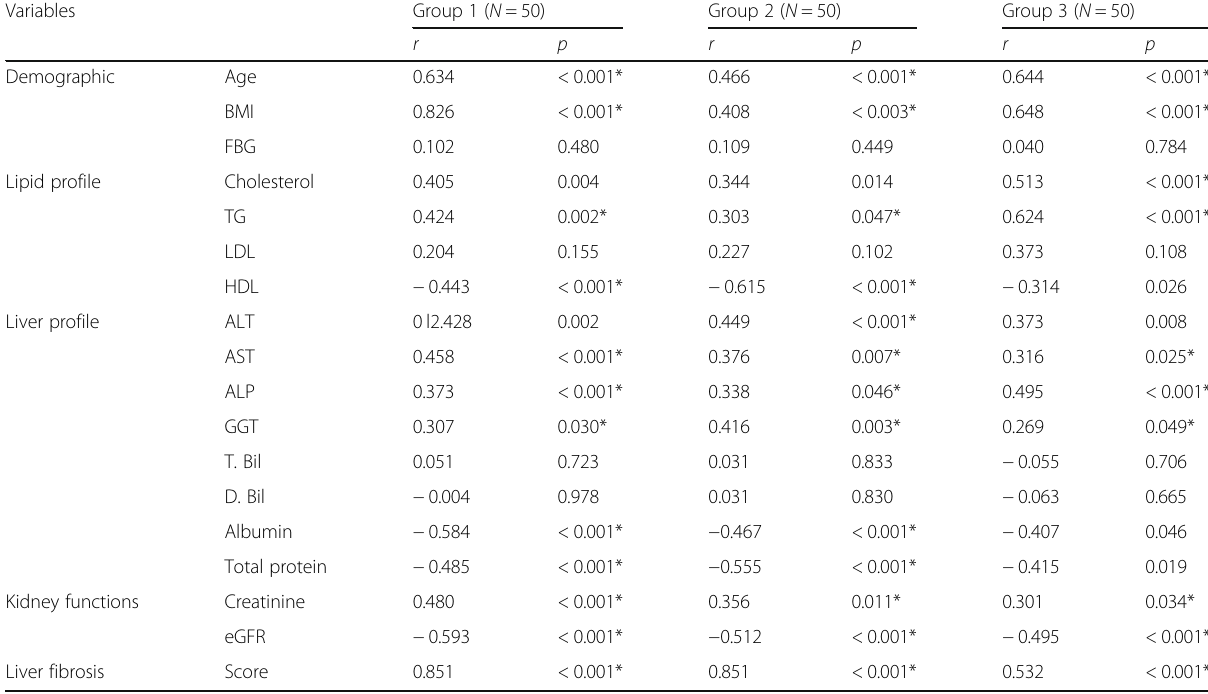
Table 3 Correlation between RRI and demographic and laboratory variables among the studied groups using Pearson correlation Variables